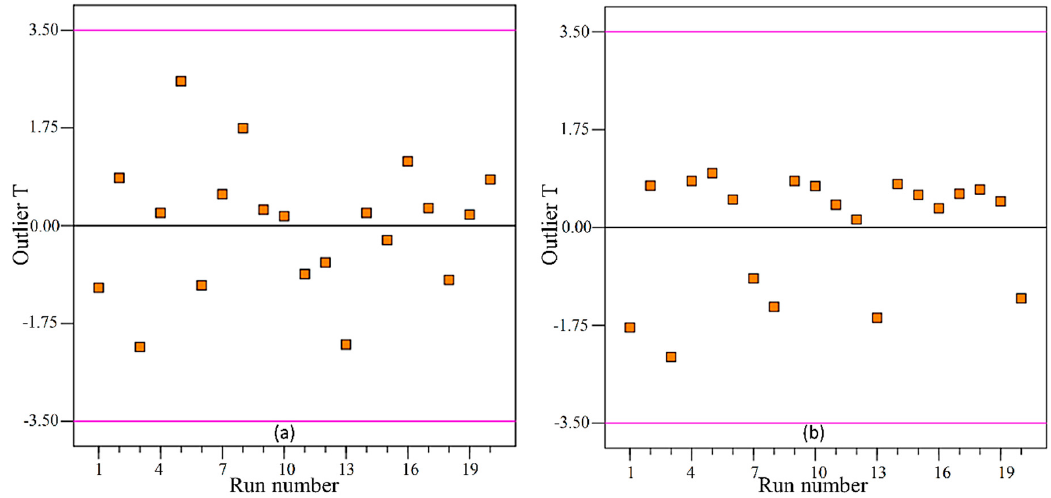
Figure 6. Outlier plot for ( a ) average roughness (Sa); ( b ) maximum roughness height (Sz).